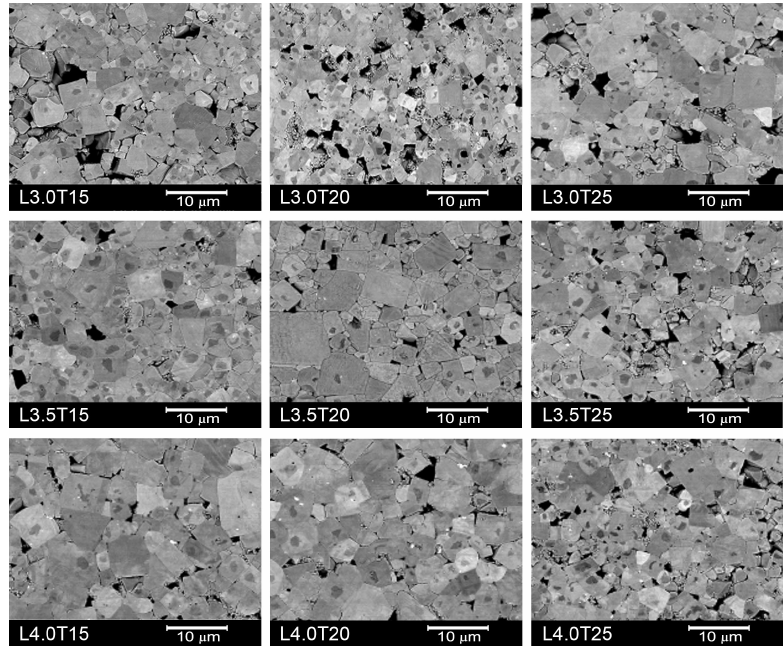
Figure 7. SEM micrographs of the studied LKNNT ceramics, sintered at 1110 ◦ C for 2